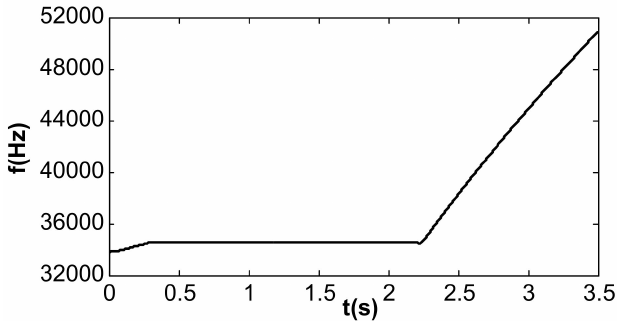
Figure 20. Frequency tracking under double closed loop ( k I = 240, k II = 2).